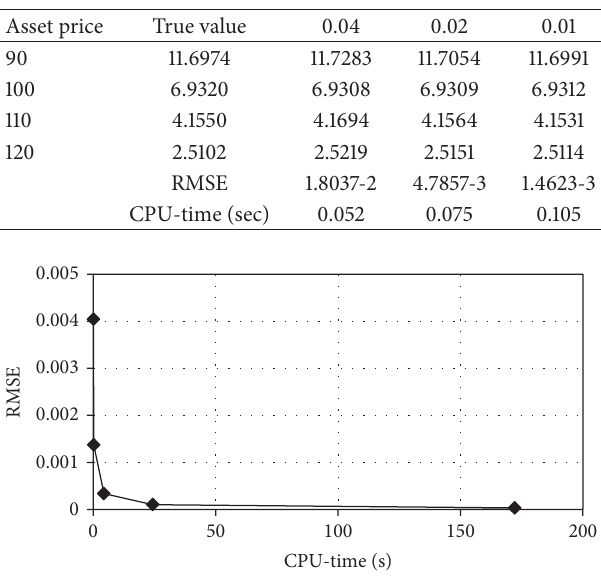
Table 1: Convergence in space for fixed time step 𝑘 = 2⋅10 −3 for the problem with parameters (56).